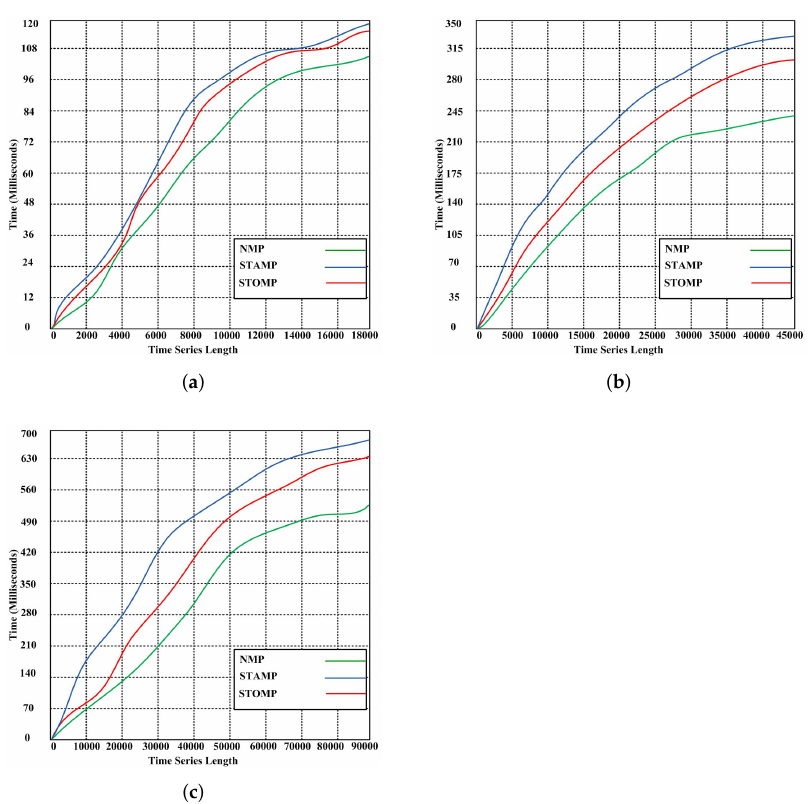
Figure 4. ( a ) Run-time execution of NMP, STAMP, and STOMP with a maximum query length of 18,000. ( b ) Run-time execution of NMP, STAMP, and STOMP with a maximum query length of 45,000. ( c ) Run-time execution of NMP, STAMP, and STOMP with a maximum query length of